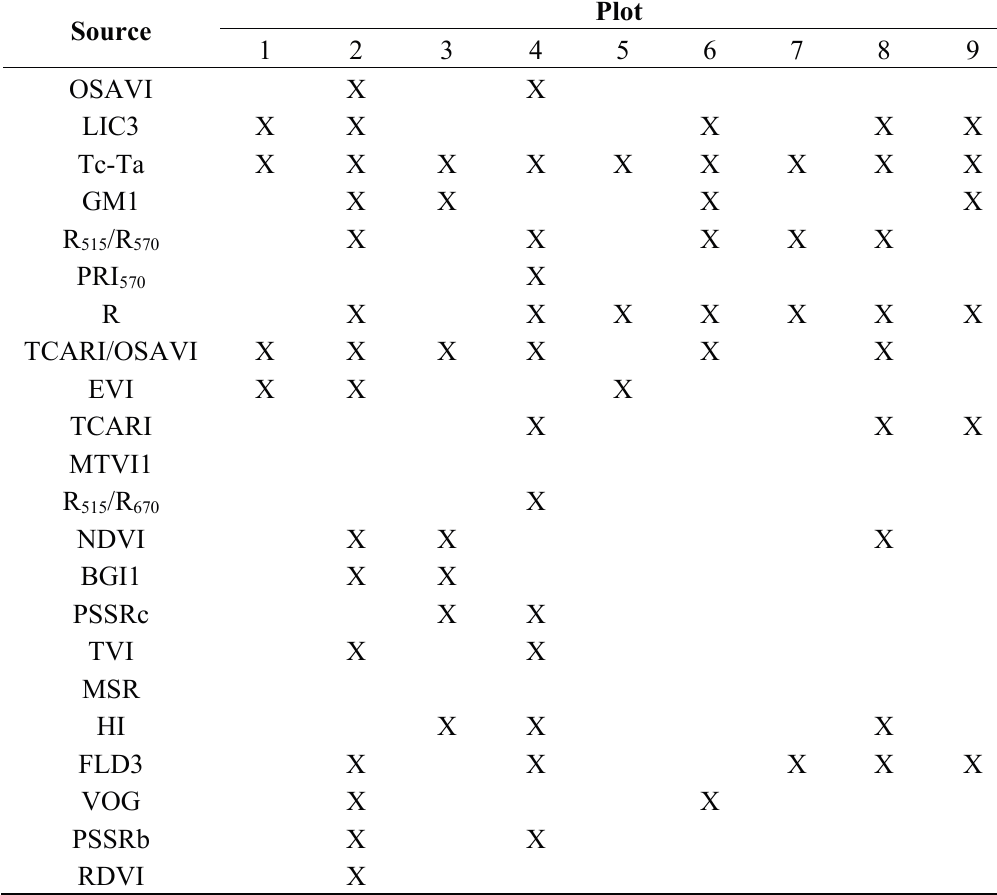
Table 10. Variables selected in the forward stepwise discriminant analysis to distinguish among Verticillium wilt severity levels for each individual plot